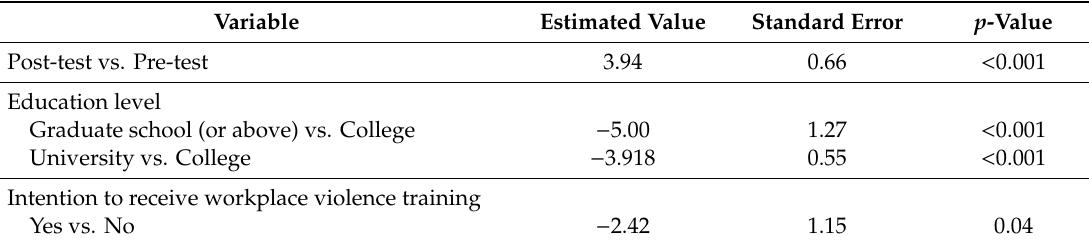
Table 5. Comparison of pre- and post-test of confidence in coping